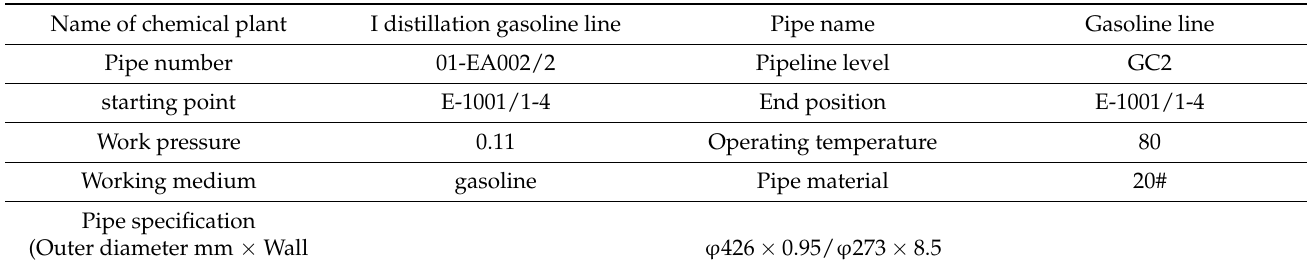
Table 9. The parameters of the pipe fittings of